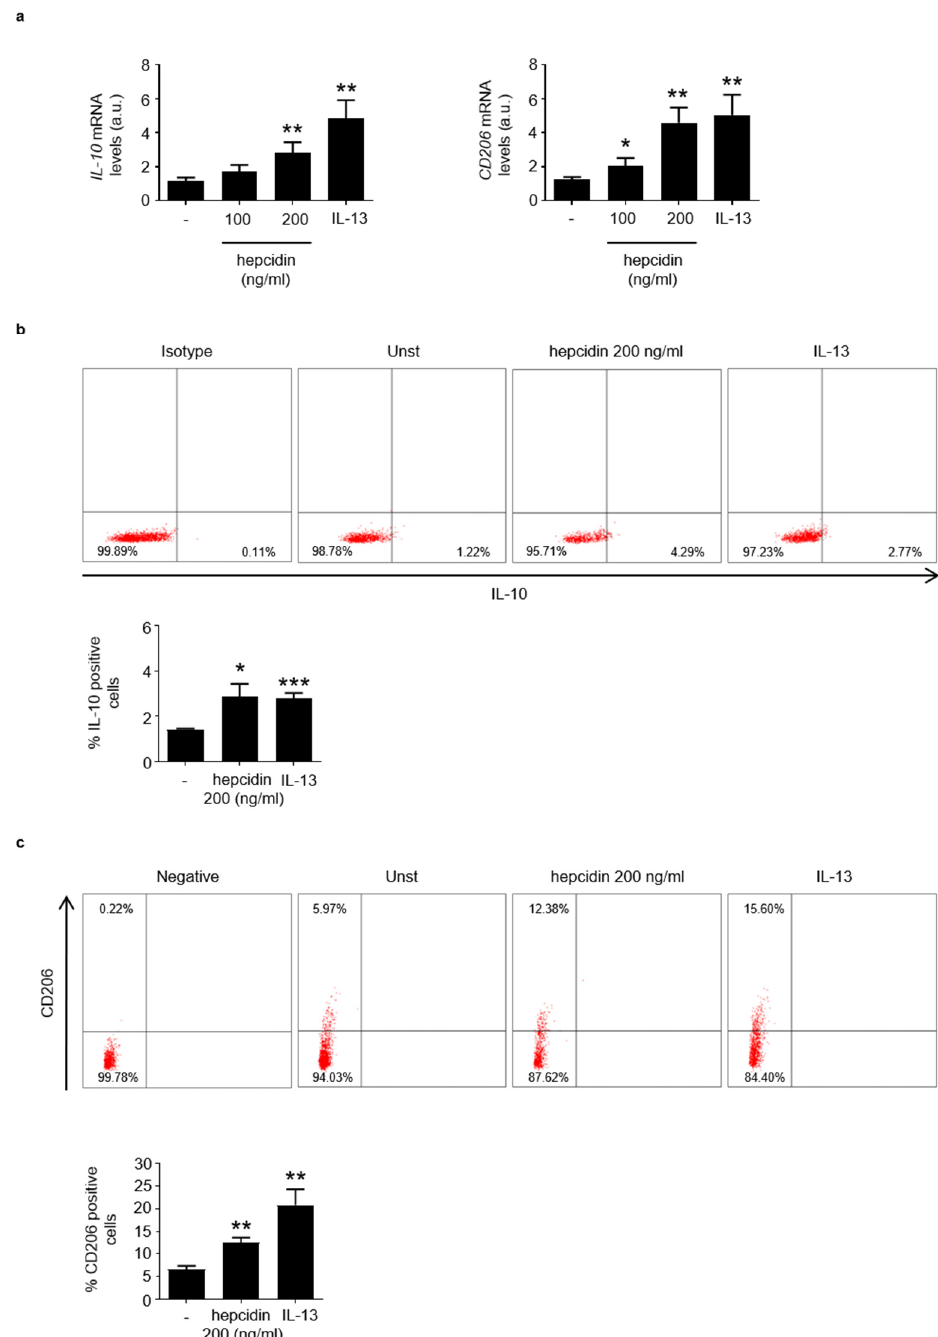
Figure 5. Stimulation of blood mononuclear cells with hepcidin increases the percentages of IL-10- and CD206-expressing cells. ( a ). Blood mononuclear cells were either left unstimulated (Unst) or stimulated with exogenous hepcidin or IL-13 (as an inducer of regulatory macrophages), as indicated in materials. IL-10 and CD206 RNA expression was analyzed by real-time PCR and values were normalized to β -actin RNA. Values are expressed in arbitrary units (a.u.) and indicate mean ± SD of 3 experiments. Unst versus hepcidin, * p < 0.05, ** p < 0.01; unst versus IL-13, ** p < 0.01. ( b , c ). Blood mononuclear cells were either left unstimulated (Unst) or stimulated with exogenous hepcidin as indicated in materials and methods and the percentages of IL-10- or CD206-expressing cells were then evaluated by flow-cytometry. The histogram shows the percentage of positive cells and data are expressed as mean ± SEM of 3 separate experiments. Unst versus hepcidin * p < 0.05, ** p < 0.01; unst versus IL-13, * p < 0.0.5, *** p < 0.001.